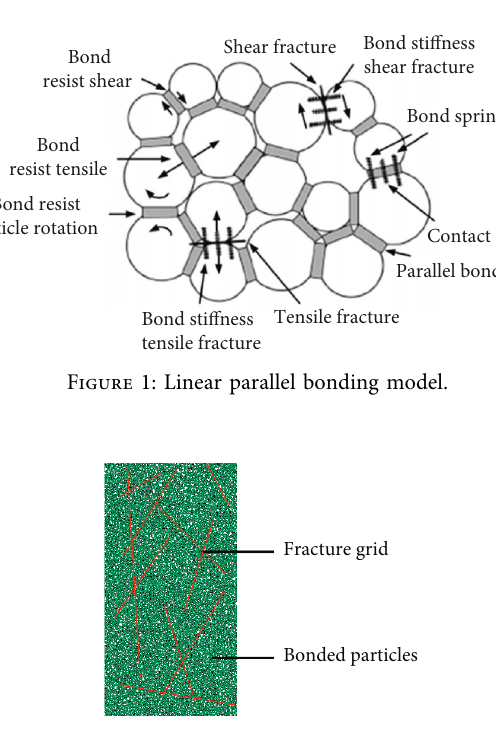
Figure 2: Synthetic rock mass map.